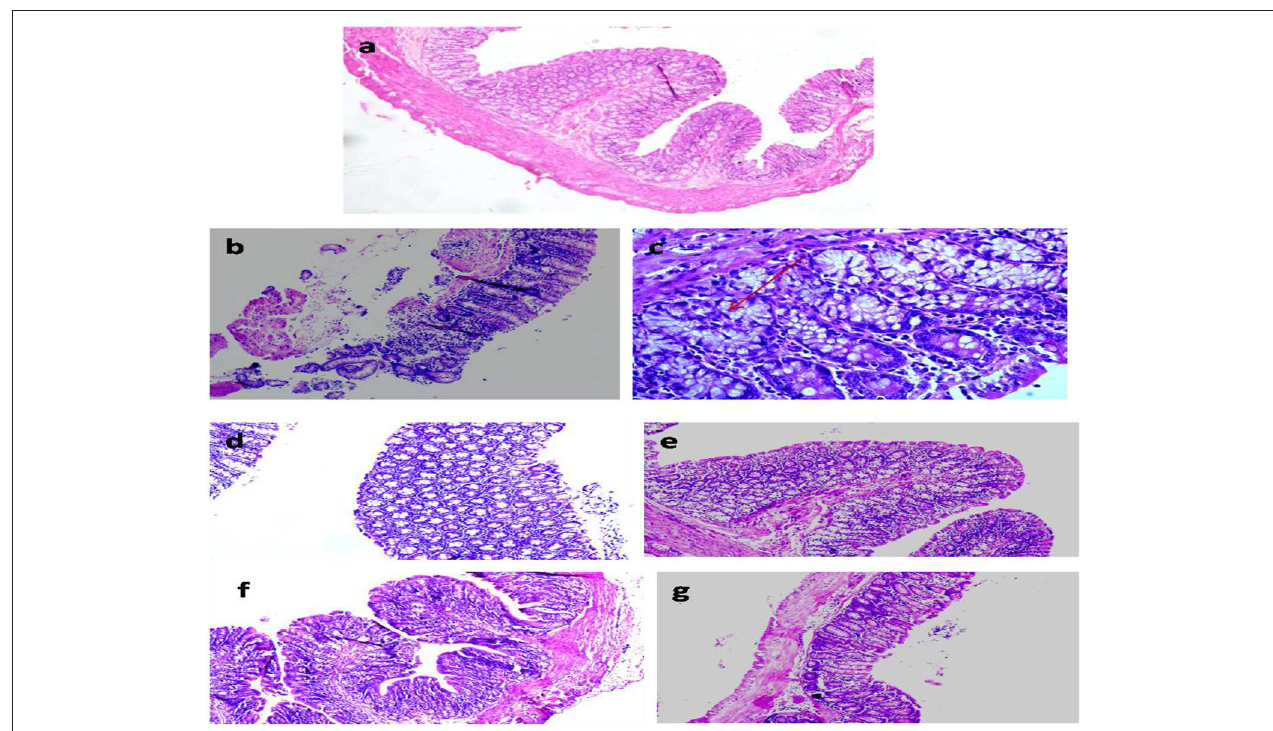
FIGURE 7 | Photomicrograph of the colon of animals belonging to different groups showing (a) normal histoarchitecture in control; (b,c) severely damaged mucosa and aberrant crypt foci (ACF) (arrow) in 1,2-dimethylhydrazine (DMH)-treated; (d) normal colon cells in metabiotic extract (ME); (e) colitis in LDME + DMH-treated; (f,g) mild inflammation in MDME + DMH and HDME + DMH-treated (H&E staining, 100 ×